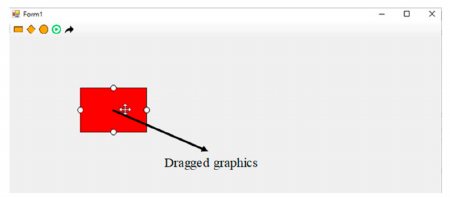
Figure 9. Graphic drag test.